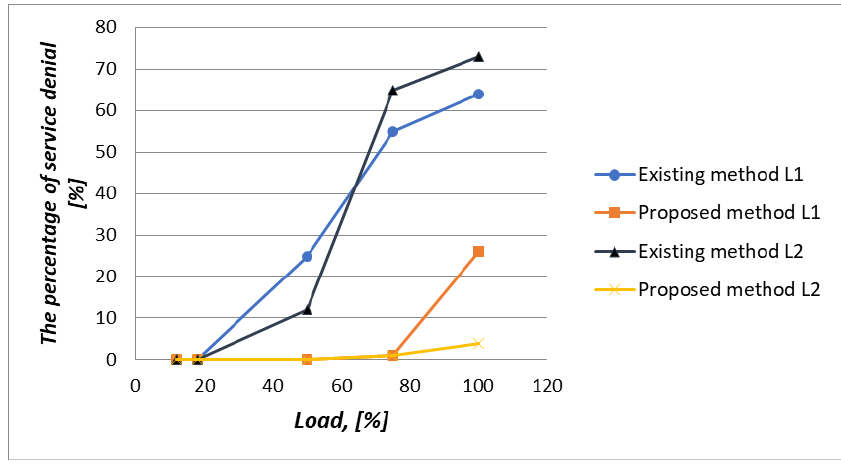
Figure 26. Service denials for priority devices (IoT devices of classes L1 and L2) with existing and proposed methods.